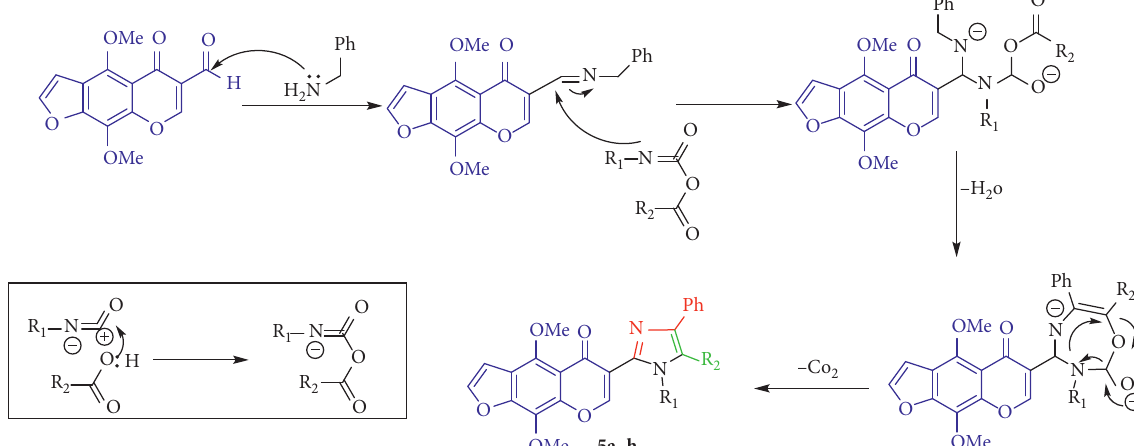
Scheme 4: Proposed mechanism for formation of compounds 5a–h